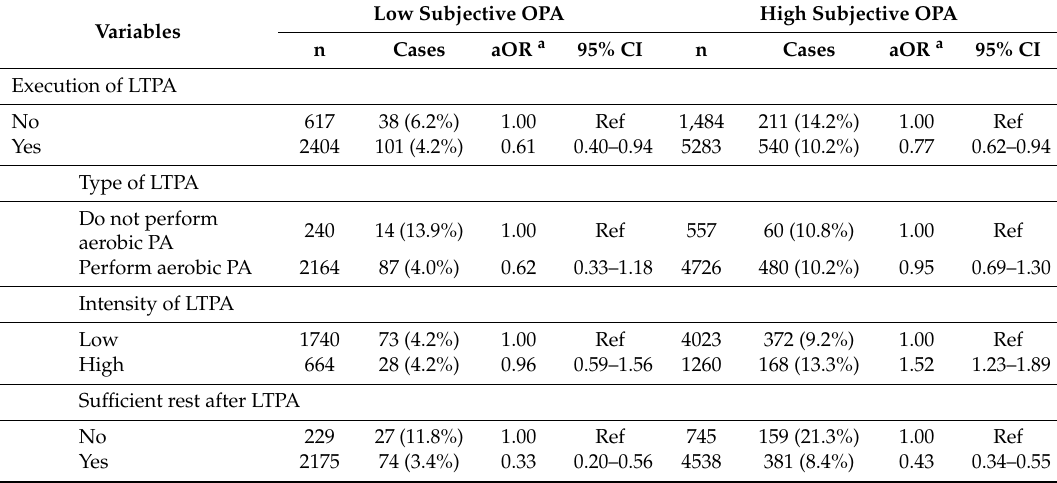
Table 4. Association between leisure time physical activity (LTPA) and insomnia according to subjective occupational physical activity (subjective OPA). [aOR = adjusted odds ratio; CI = confidence interval].